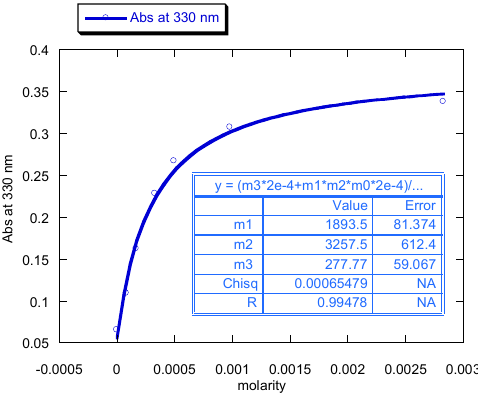
Figure 2 . The plot of Abs vs. molarities of the ligand for cis-[Pt( p -Tol)